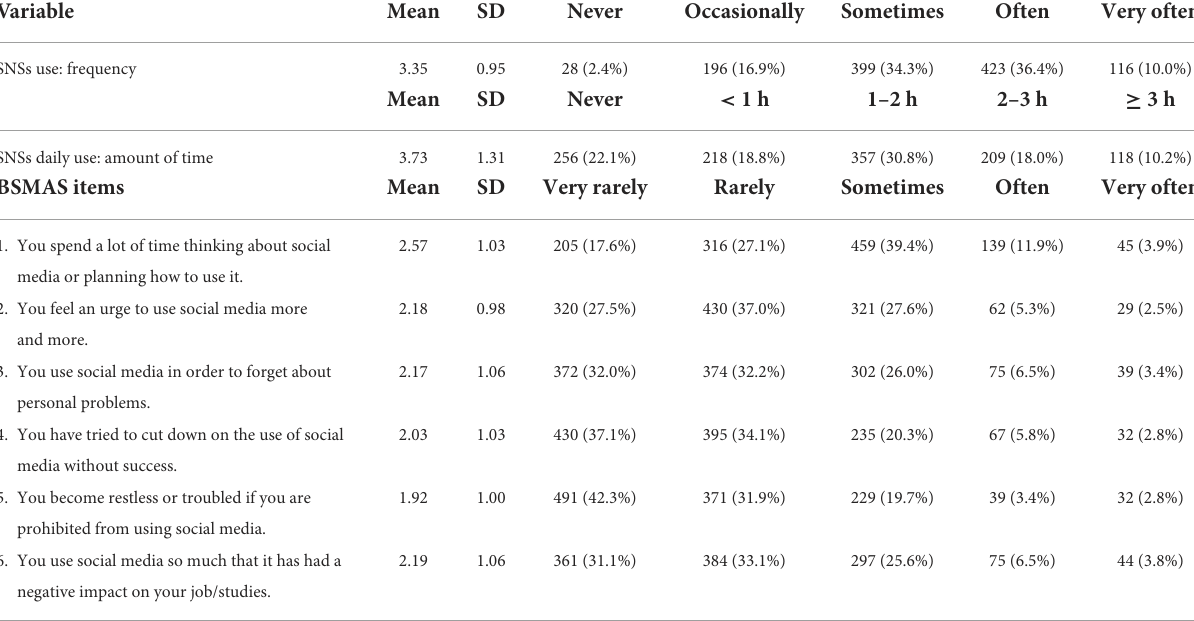
TABLE 2 Descriptive statistics of the participants’ levels of depression, anxiety, and stress. Variable